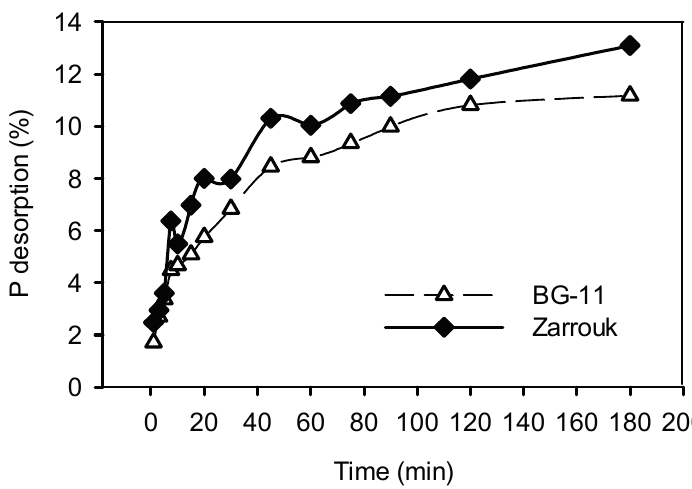
Figure 2. Desorption kinetics of P from P-loaded zeolite into BG-11 and Zarrouk cultivation media. P-loaded zeolite concentration: 2.5 g/L.